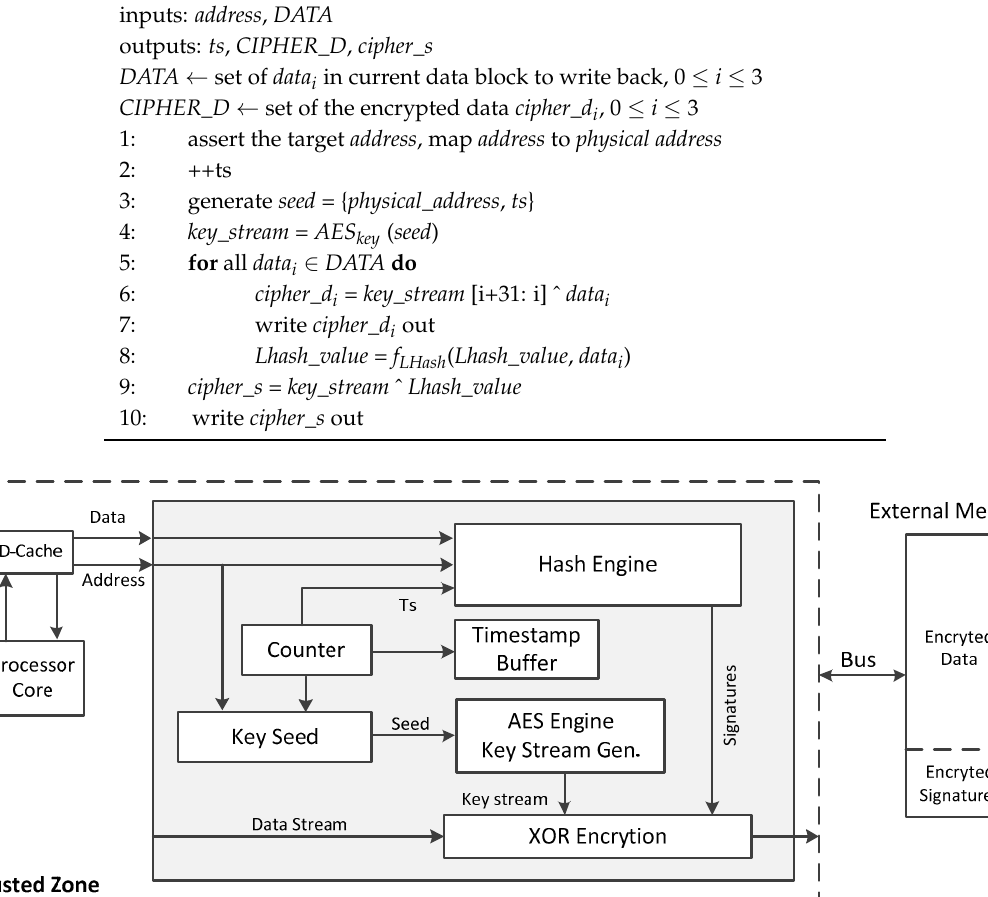
Figure 8. The hardware details of the data write-back operation.